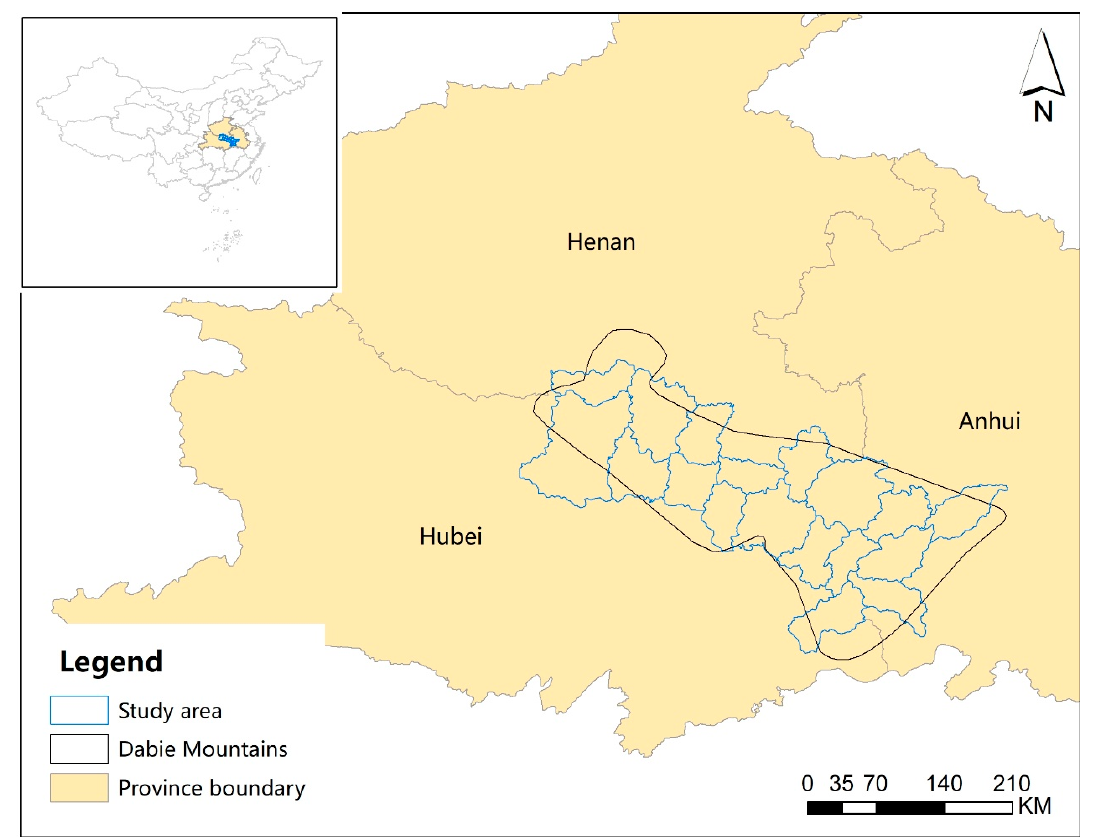
Figure 1. Study area in the Dabie Mountains, China. KM means kilometer.